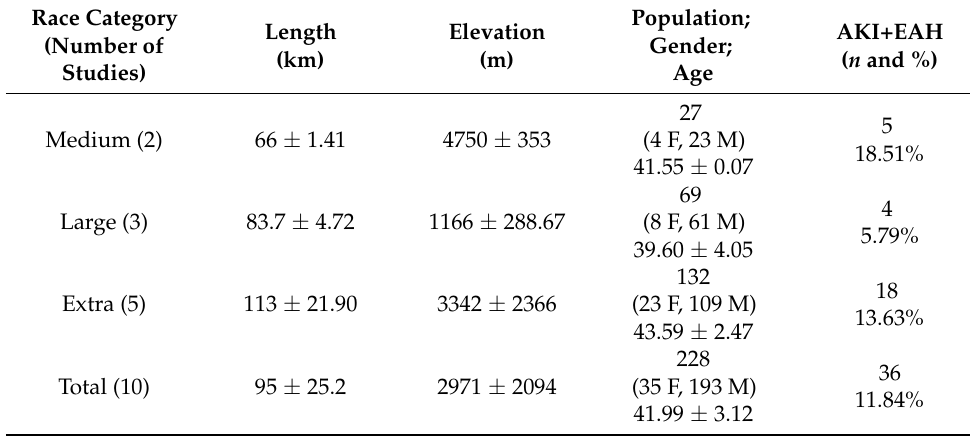
Table 5. AKI+EAH cases sorted by race